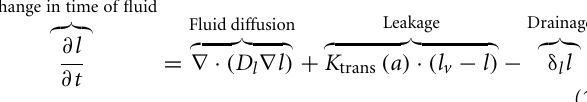
FIGURE 3 | Schematic of the PIHNA-E model. The main components of the model are seen in the flow chart: c represents the normoxic glioma cells, h the hypoxic gliomas cells, v the vascular endothelial cells, n the necrotic cells, a , the angiogenic factors, and l the edematous fluid. Depending on the level of oxygen, normoxic, and hypoxic cells will undergo phenotypic switching. If oxygen levels fall too far and are not compensated for by sufficient angiogenesis, the hypoxic cells will undergo necrosis. Additionally, all cells will undergo necrosis if in contact with